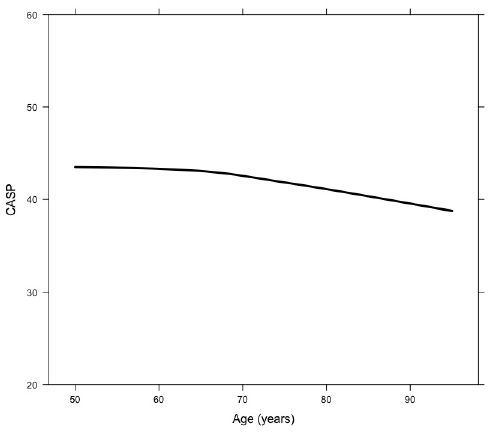
Figure 1. Mean CASP-12 trajectory across age.